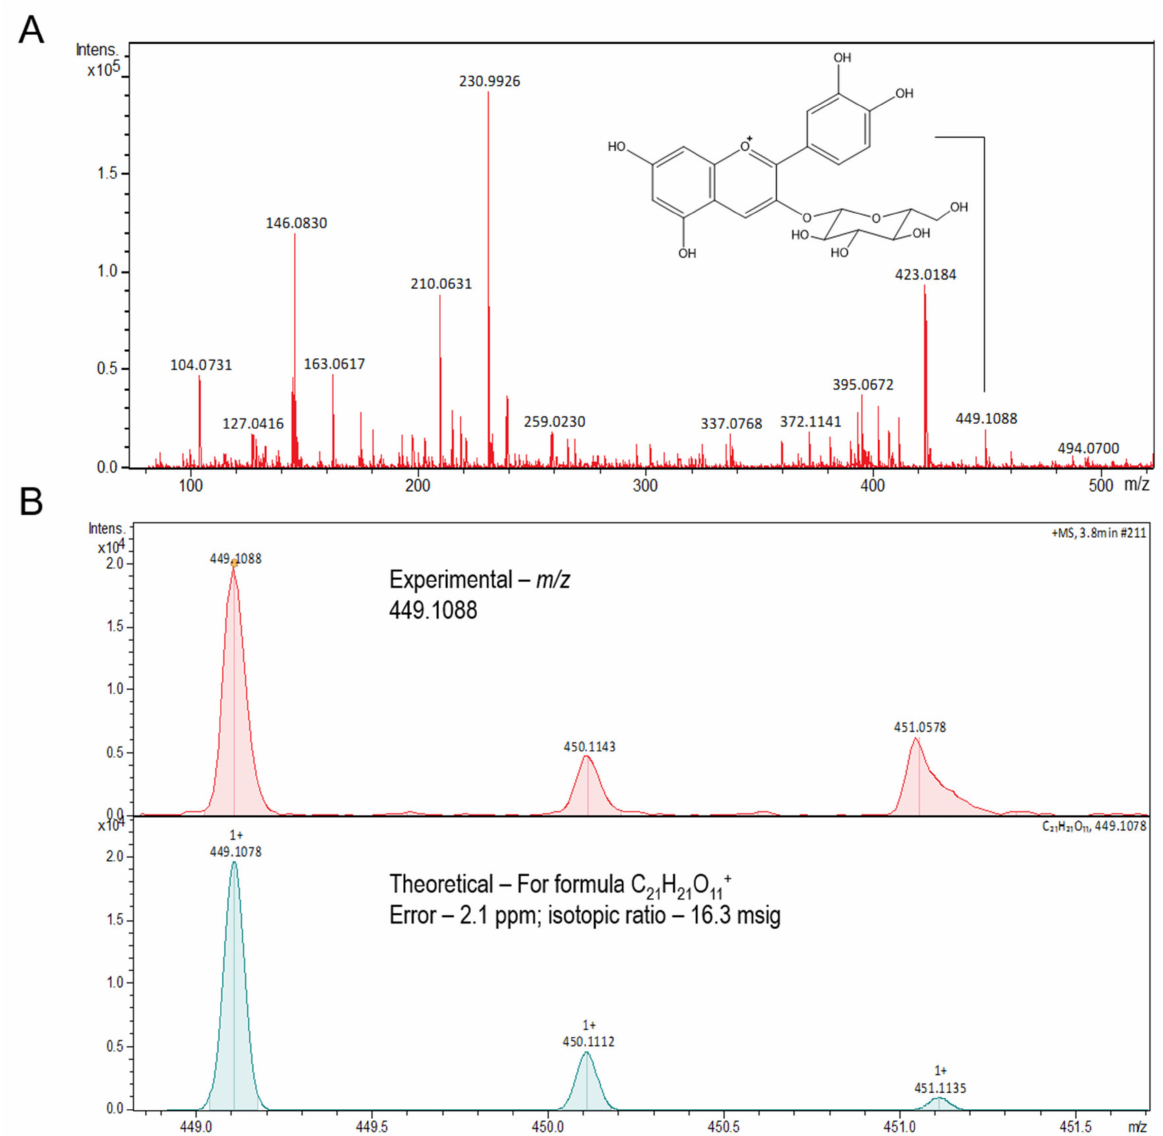
Figure 2. Full mass spectrum of the extract of Plinia trunciflora showing the compound cyanidin-3-O- glucoside ( m / z 449.1088) ( A ). The tandem mass spectrometry (MS–MS) of cyanidin-3-O-glucoside ( m / z 449.1088) from the extract of Plinia trunciflora ( B